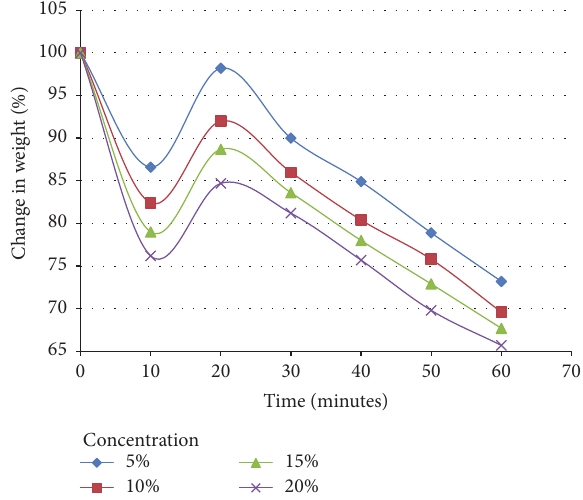
Figure 4: Degradation profile of Aloe vera /polymer films with varying concentration. Time in minutes is shown on 𝑥 -axis and % change in weight is shown on 𝑦 -axis.